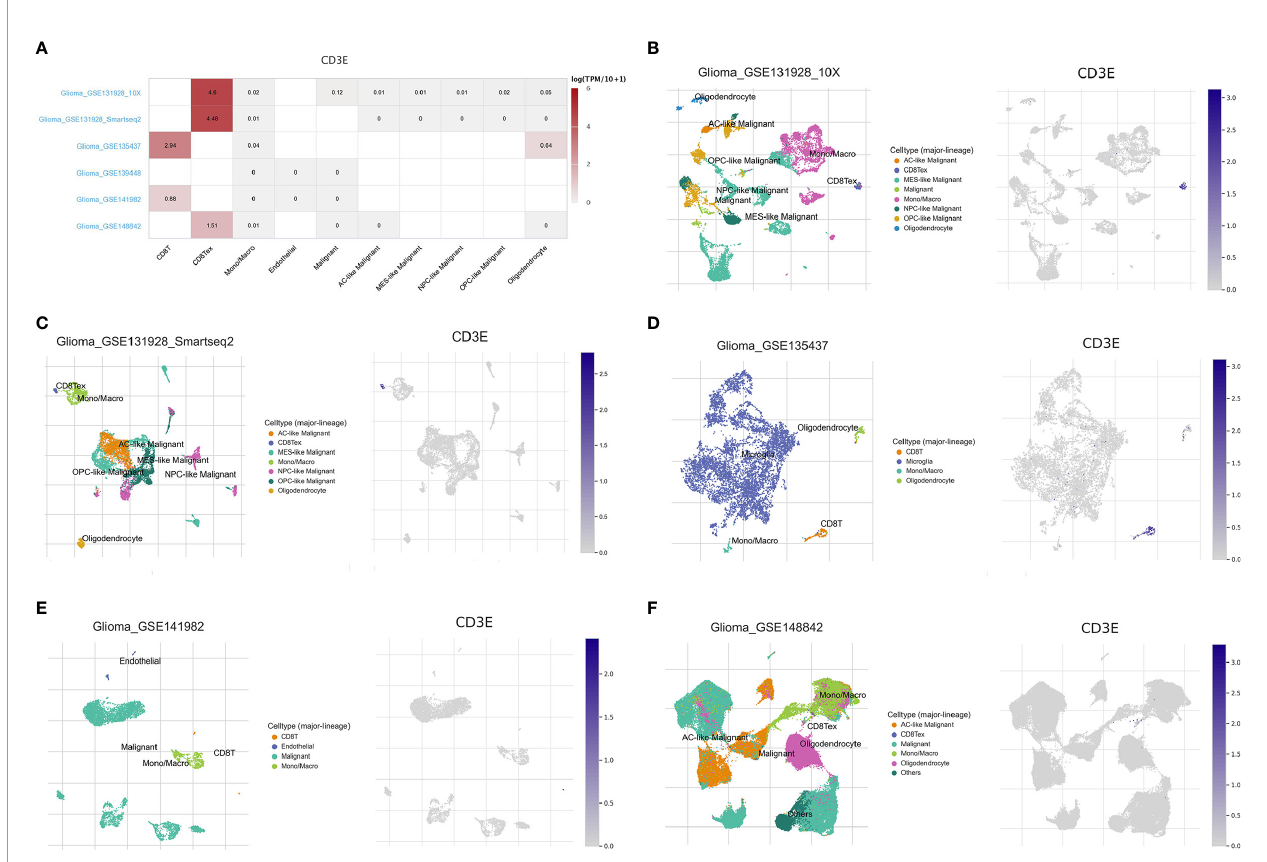
FIGURE 11 | Single cell analysis of CD3E in LGG. Six single cell sequencing data sets from geo analysis were used to analyze the expression of cd3e in CD8 + T cells. (A) We quantitatively calculated the positioning and binding of CD3E on various immune cells across the dataset using a heatmap. (B – F) Five single-cell RNA- seq datasets were enrolled to determine the location of CD3E in different